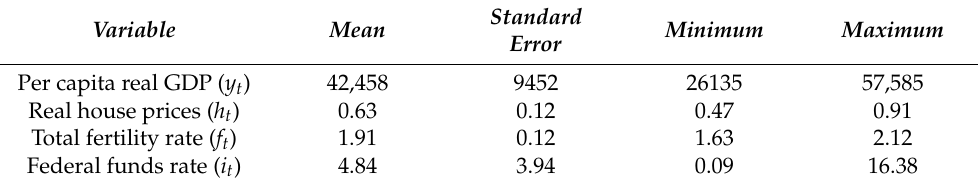
Table 1. Summary statistics of the variables for the period of 1975–2020.